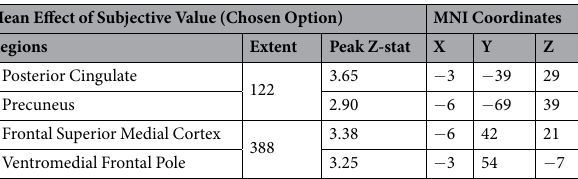
Table 2. Average neural representations of subjective value of the chosen option. Average effects are reported across 21 subjects. Showing local maxima separated by 20 mm for cluster-forming threshold Z > 2.3, cluster- corrected p <